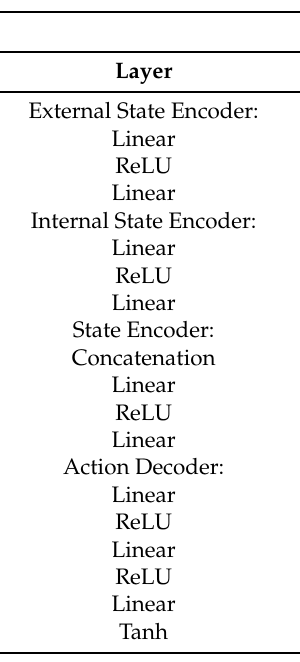
Table 1. Network parameters and structure of actor network.